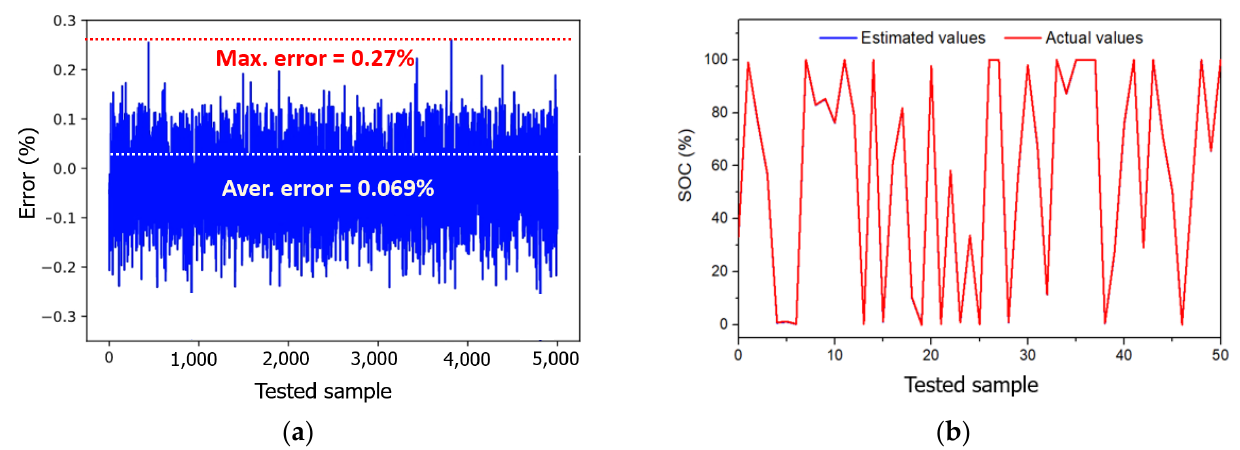
Figure 14. Test results of the redesigned ANN with 5,000 random samples: ( a ) error of estimated SOC, and ( b ) estimated and actual SOCs.